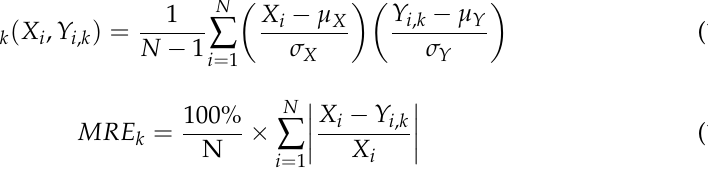
Figure 7. Rain-induced attenuation at 71 GHz on 7 January 2020, black line: rain-induced attenuation after correction; blue line: predicted from link data; red line: estimated from DSD data; green line: using the method recommended by ITU-R P.838-3.